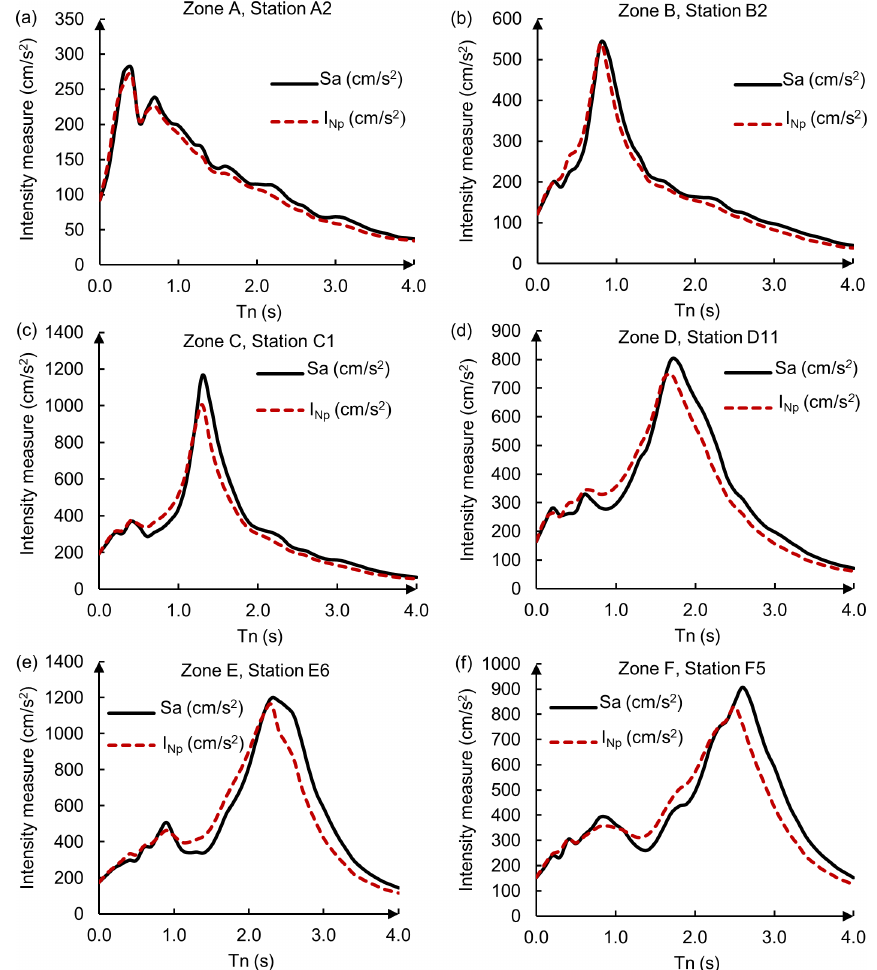
Figure 7. Uniform hazard spectra of Sa( T 1 ) and I N 250-year return interval.